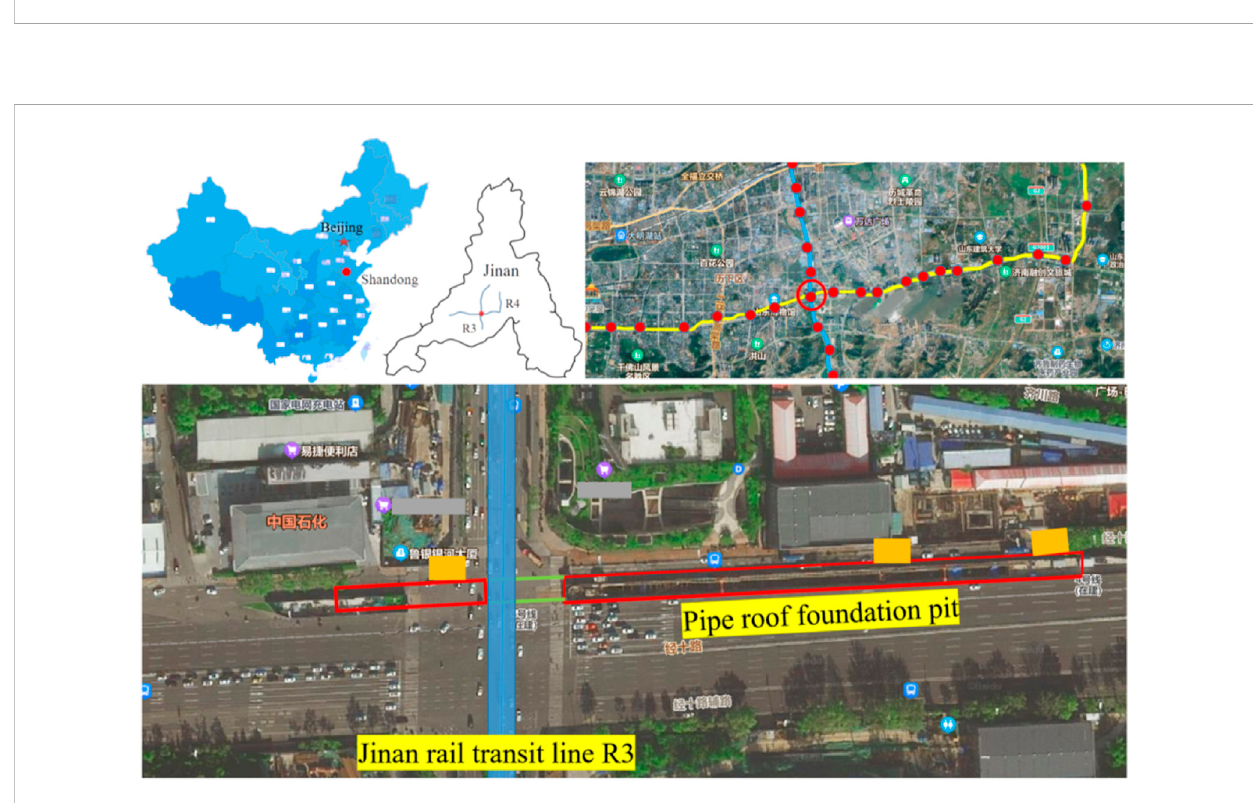
FIGURE 2 Geographical location of the